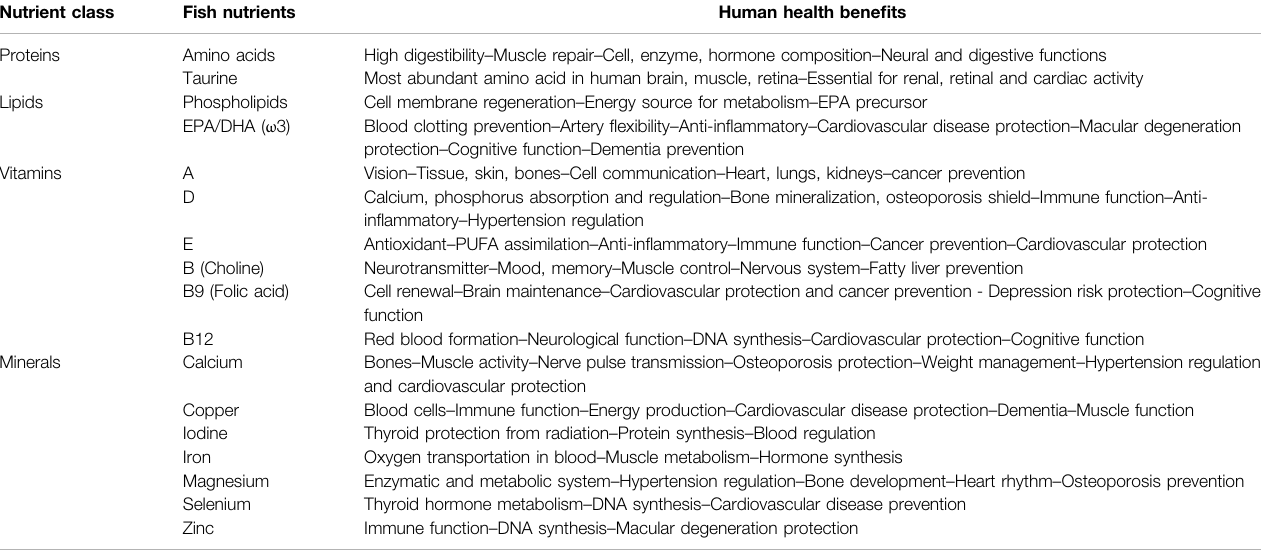
TABLE 1 | Micronutrients and human nutritional bene fi ts found in fresh fi sh (adapted from Tacon et al., 2020). Nutrient class Fish nutrients Human health bene fi ts Proteins Amino acids High digestibility – Muscle repair – Cell, enzyme, hormone composition – Neural and digestive functions